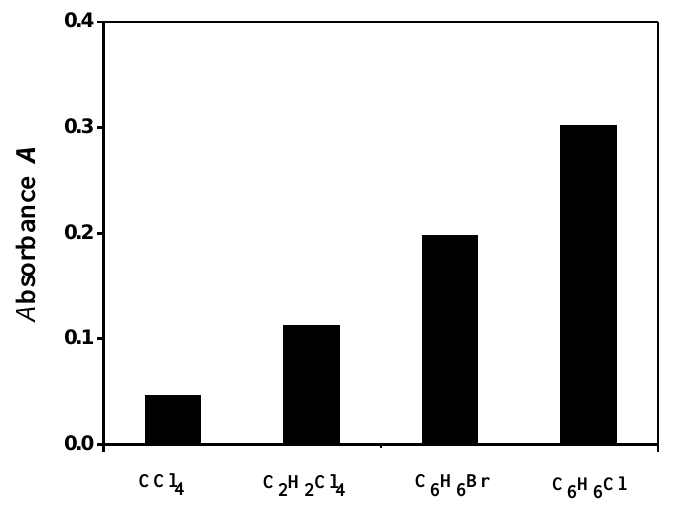
Figure 1. Effect of extraction solvent type on the extraction efficiency of Cu(II). Extraction conditions: 5.00 mL water sample, pH = 5.0, 100 µ L 5 × 10 − 4 mol/L 5-Br-PADMA, 500 µ L CH 3 CN, 40 µ L extraction solvent, and 0.5 ng Cu.